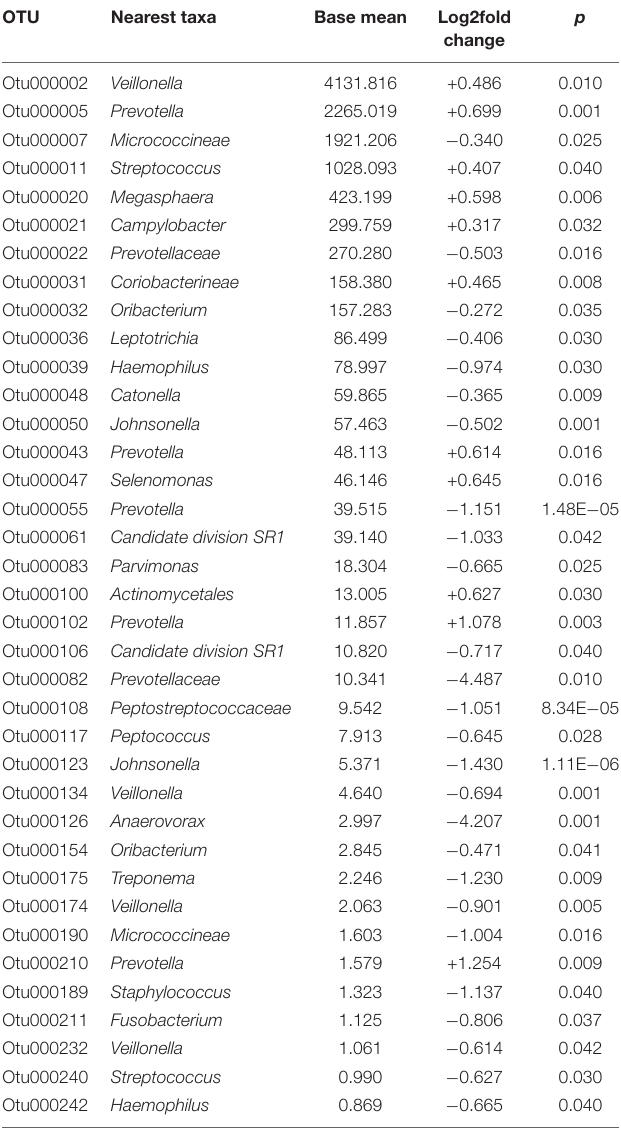
TABLE 2 | List of differentially abundant OTUs at genus level (or closest taxa) according to sweet treat consumption. OTU Nearest taxa Base mean Log2fold